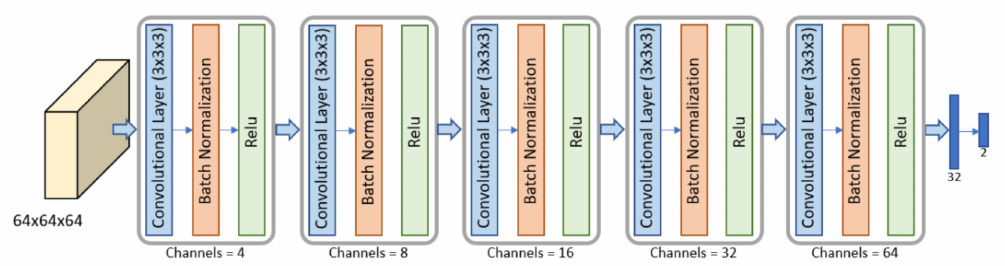
Figure 2. Architecture of the VB-NET used for the SVB. The VB-NET is a 3D CNN with five reduction blocks and two fully connected